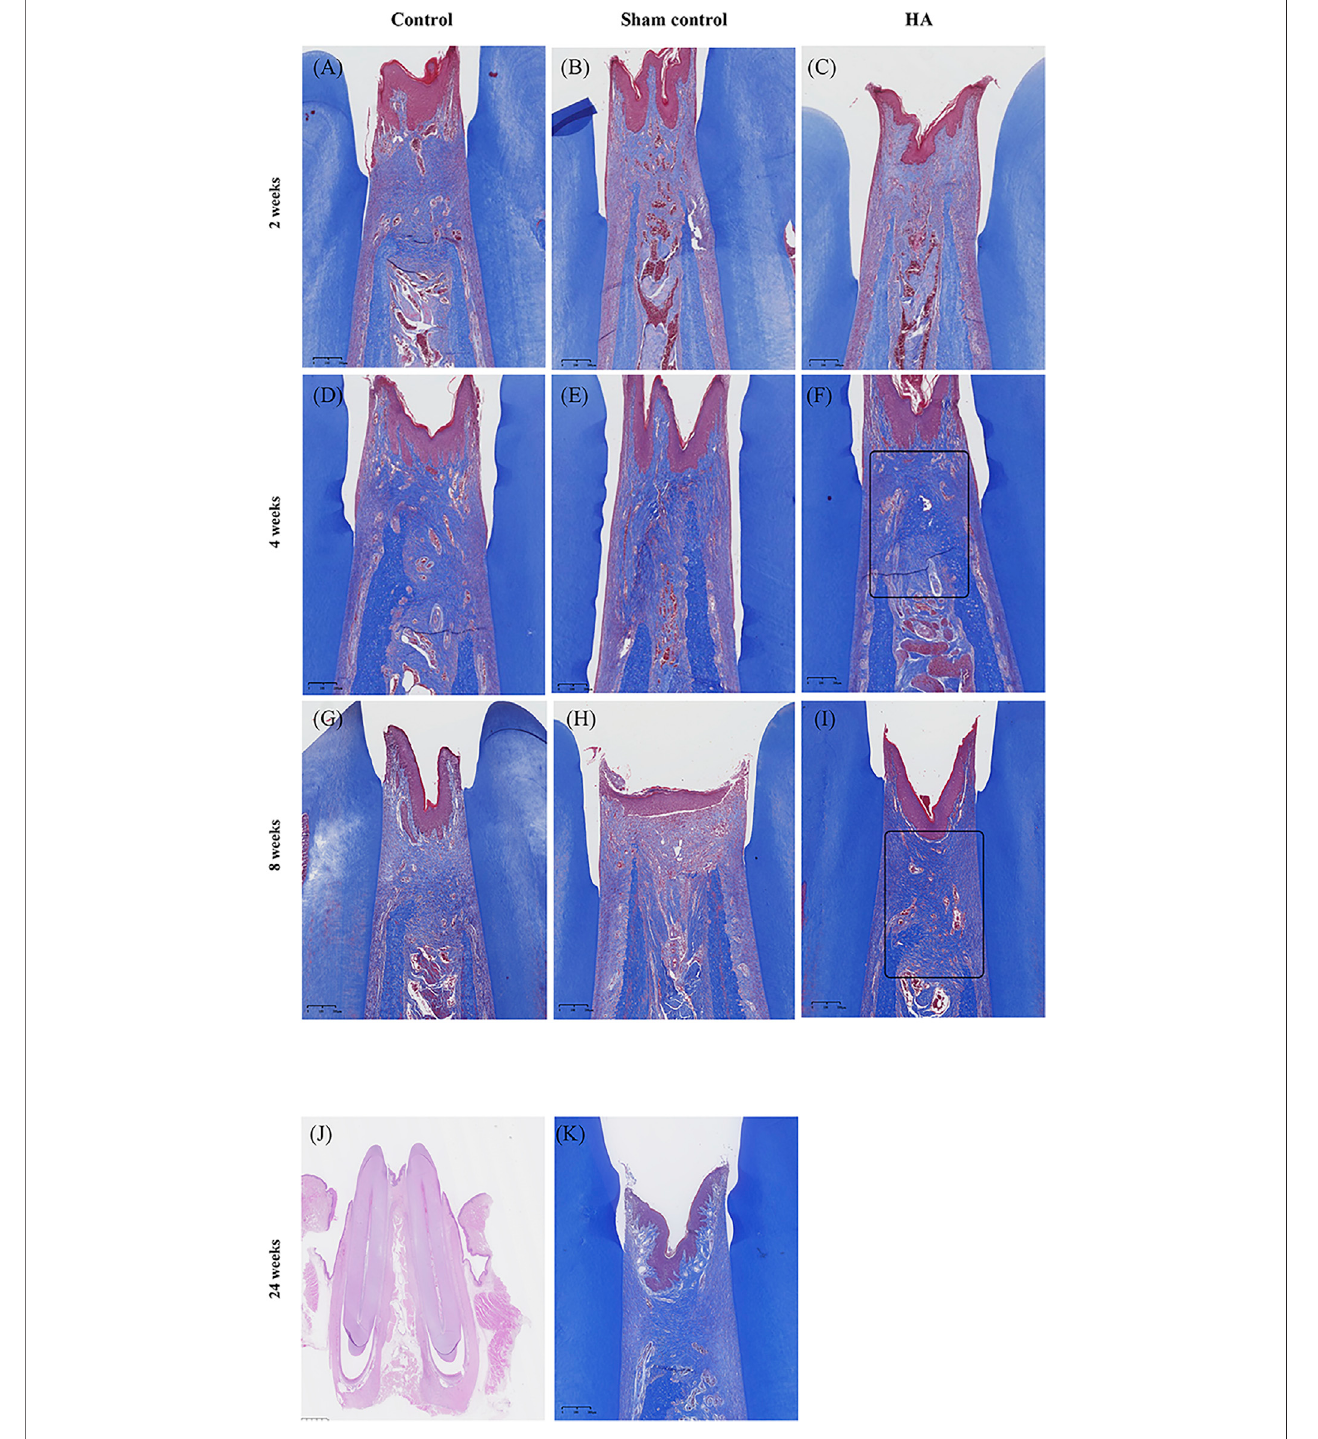
FIGURE4| Photo-scanningofMassonTrichromestainingshowingthecollagen fi berformationintheinterdentalpapilla.Controlgroupat2 (A) ,4 (D) ,and8weeks (G) . Sham control group at 2 (B) , 4 (E) , and 8 weeks (H) . HA group at 2 (C) , 4 (F), and 8- weeks (I) , n (cid:1) 5. Collagen fi bers are presented as a collection of dense bluish colorswiththeMassonTrichromestain.They aremoreprominentat4and 8weekspostinjectionintheHAgroup(blacktriangle).NoHA fi llerremained at24weeksafter injection (J), scale bar (cid:1) 1 mm and mature collagen fi bers formed in the interdental papilla (K) , n (cid:1) 2. Scale bars (cid:1) 200 μ m.